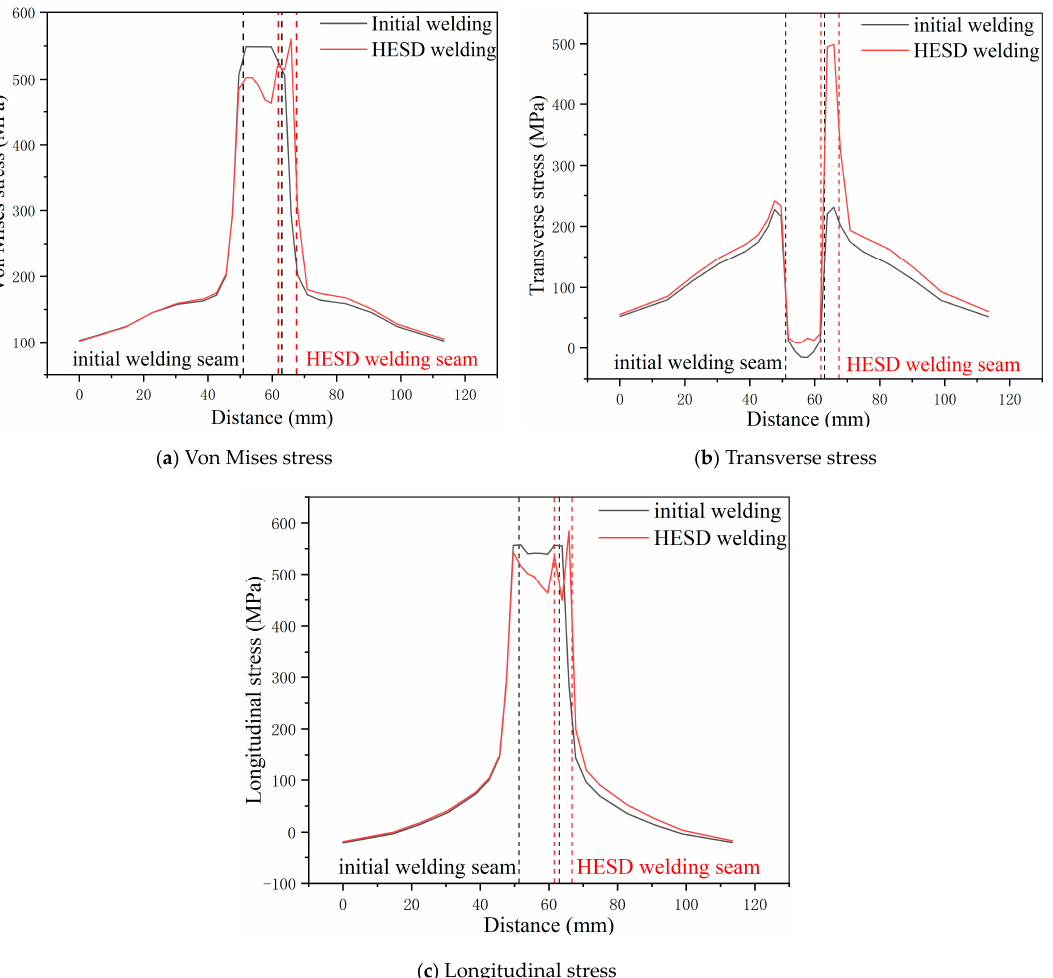
drawn. In the Figure 19 the initial welding seam is located between the black dotted lines, and the HESD welding seam is located between the red dotted lines.